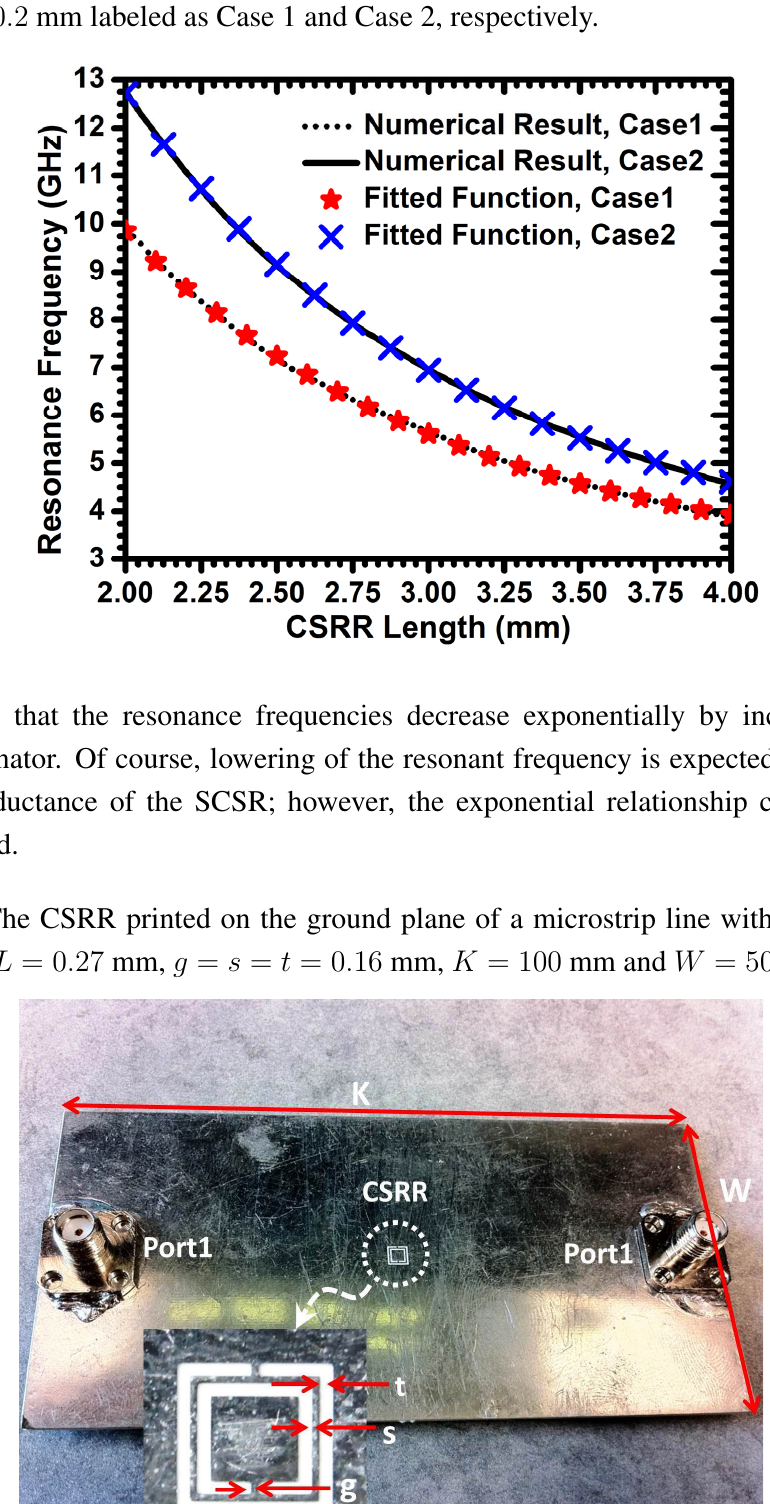
Figure 3. Resonance frequencies versus CSRR length obtained form full-wave numerical simulation and from the fitting exponential function for gap separations and trace widths of 0 . 1 mm and 0 . 2 mm labeled as Case 1 and Case 2, respectively.